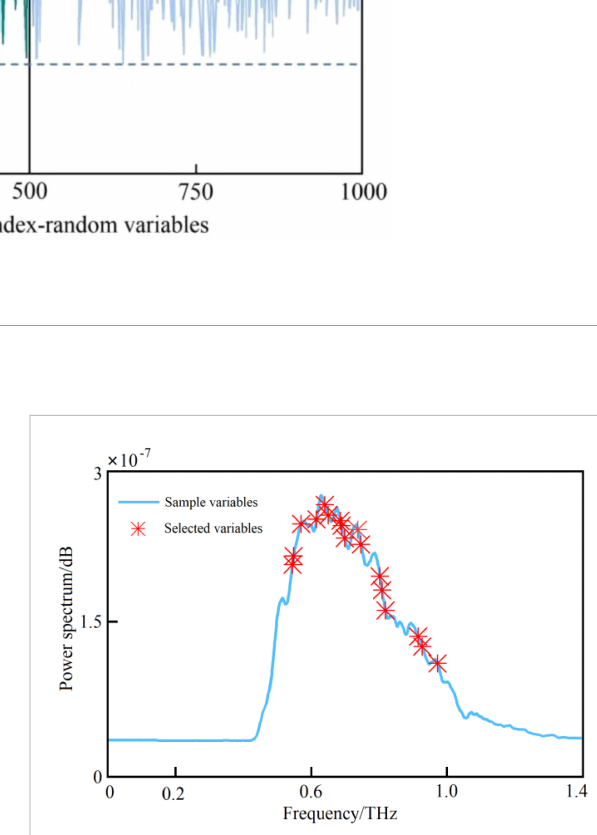
FIGURE 7 The characteristic bands selected based on the UVE algorithm.